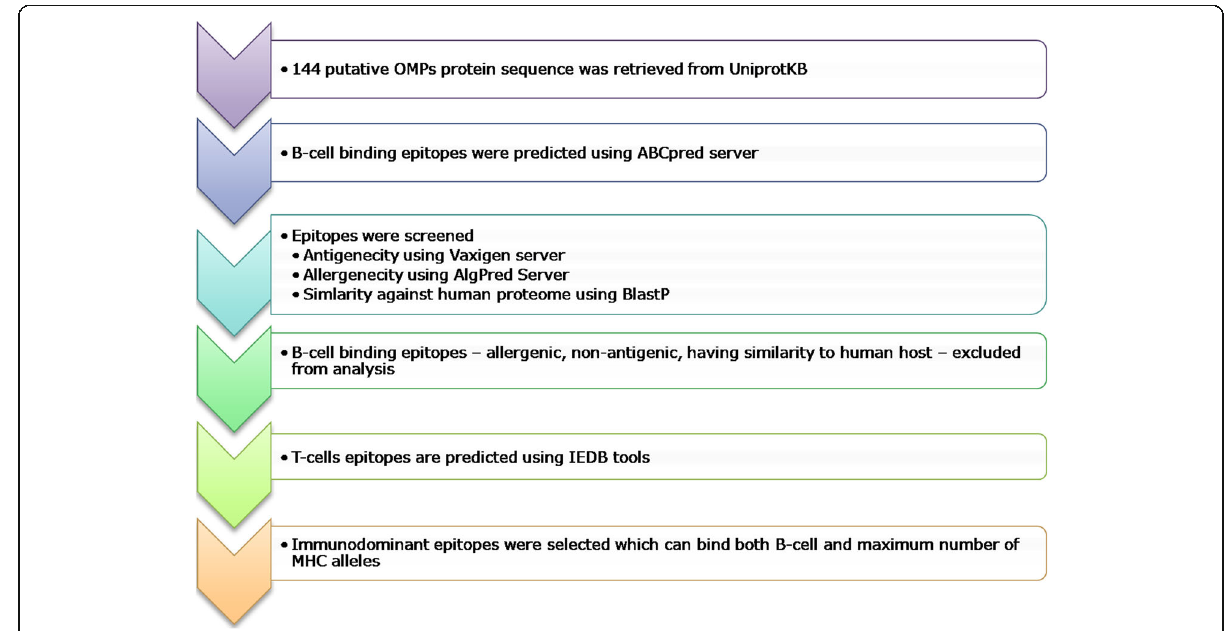
Fig. 1 The overall methodology adopted in this